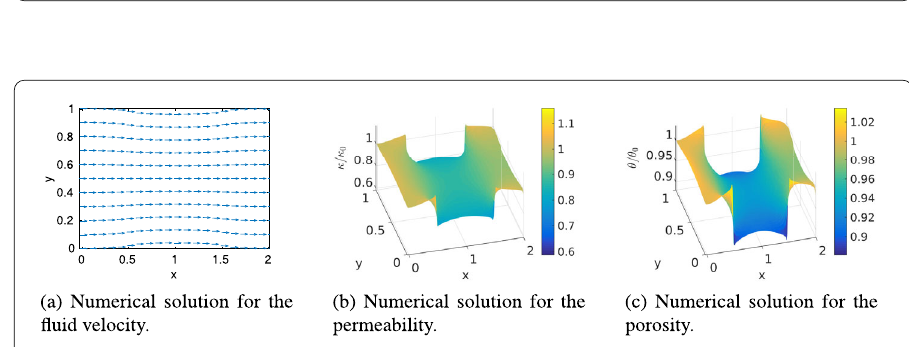
Figure 18 Numerical solutions for the fluid velocity, the permeability and the porosity, at time t = 300, obtained using the network-inspired relation with p c = 0.4935